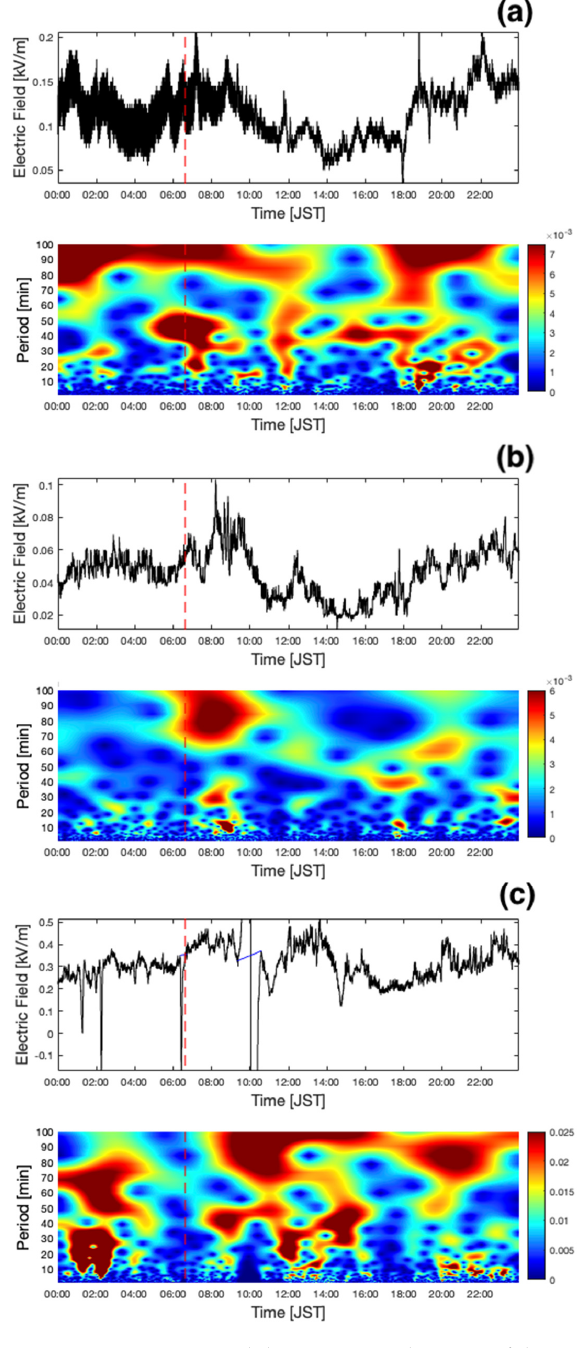
Figure 4. Time series and dynamic periodograms of the AEF for the period interval up to 100 min on the day of EQ1 (24 h): ( a ) Chofu (CHF), ( b ) Kakioka (KAK), and ( c ) Iwaki (IWK). Similar variations to CHF are seen both in the time series and the periodogram for KAK. In KAK wave-like oscillations starting around EQ1 began from 6 JST (1 h later